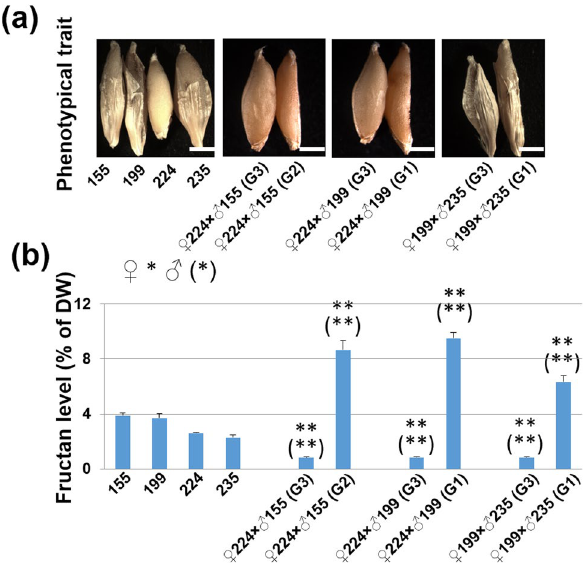
Figure 2. Fructan content assay in crossing lines of G1/G2 shape-inherited seed and G3 shape-inherited seed. ( a ) Images of the two types of F 3 grains, G1/G2 shape-inherited (G1/G2) and G3 shape-inherited (G3) grains. ( b ) Percentage per unit dry weight of fructan in different kinds of grains. Student’s t-test was used (Error bars show SD). * P < 0.05 and ** P < 0.01 or (*) P < 0.05 and (**) P < 0.01 in ( b ) are shown for significant differences between the progenies and the maternal or paternal line, respectively. Three biological replicates or grains from three independent plants ( n = 3) were used for fructan analyses. Bars = 3